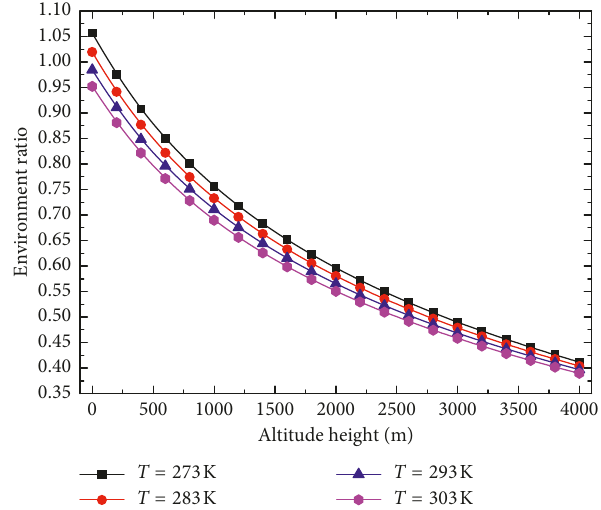
Figure 2: Change of the environment ratio with altitude of the